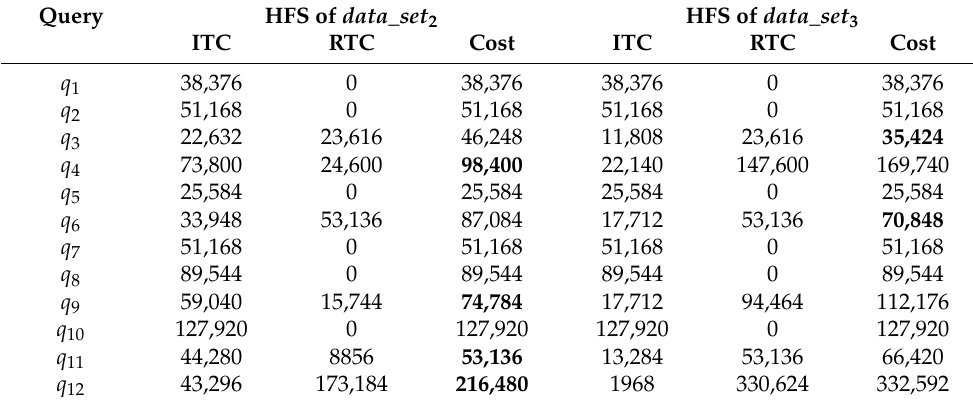
Table 15. Query cost comparison of the fragmentation